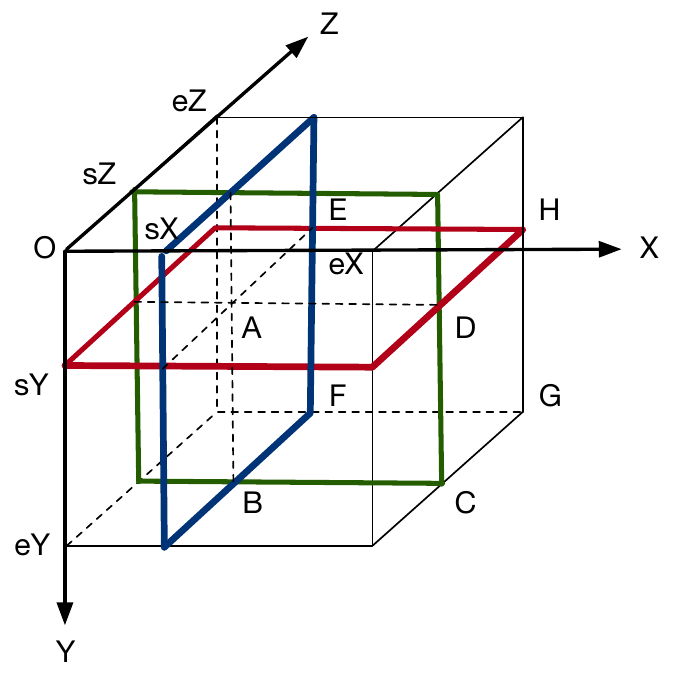
Figure 2. Specific property of 3D integral image. The sum of the intensities in region ABCD-EFGH whose diagonal starts at A: ( sX , sY , sZ ) and ends at G: ( eX , eY , eZ ) is obtained by seven